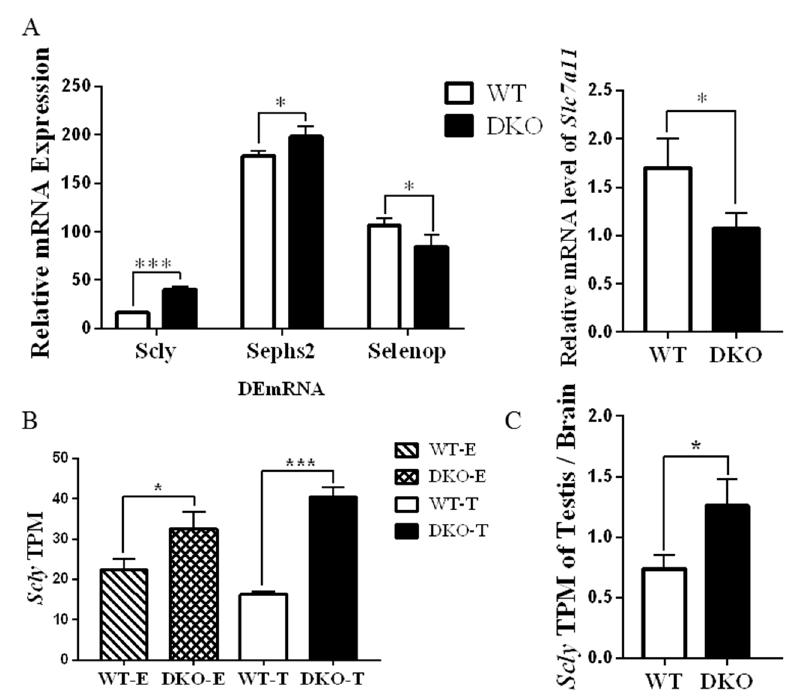
Figure 6. Expression of selenoprotein relative gene. ( A ) mRNA relative expression in TPM of Scly , Sephs2 , Selenop and Slc7a11 genes in DKO and WT testes. ( B ) DKO and WT male transcriptome Scly TPM.of testicular and brain ( C ) The ratio of DKO and WT male testicular/brain tissue Scly expression. ( n = 9, * p < 0.05, *** p < 0.001).